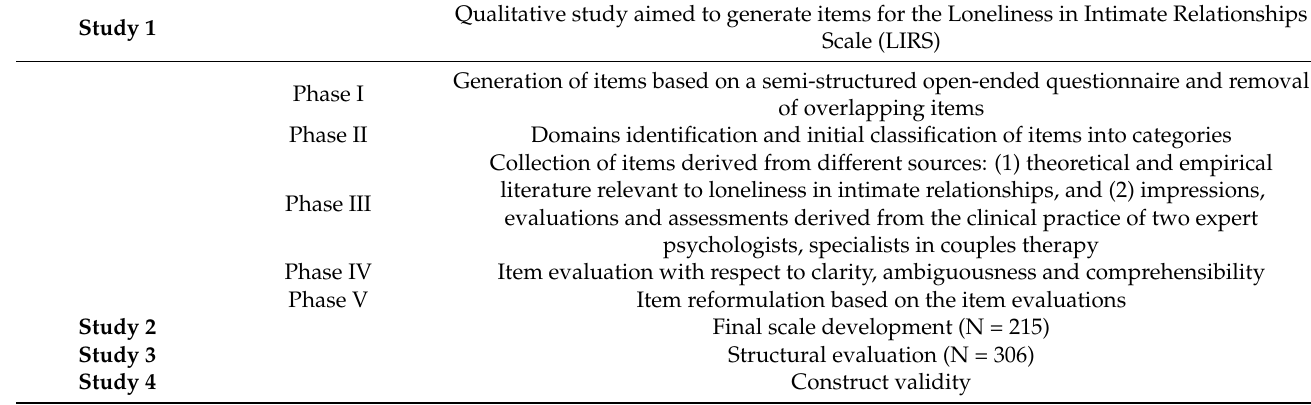
Table 1. Stages of the development of the loneliness in intimate relationships scale for